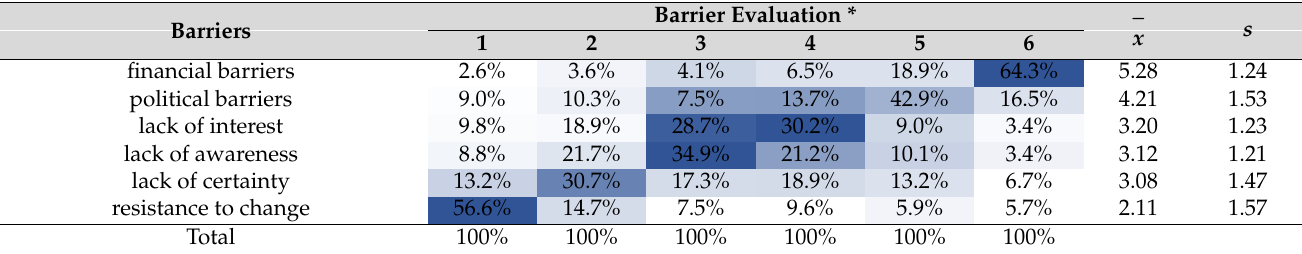
Table 10. Structure of responses regarding barriers to energy transition, as well as the average score and standard deviation.